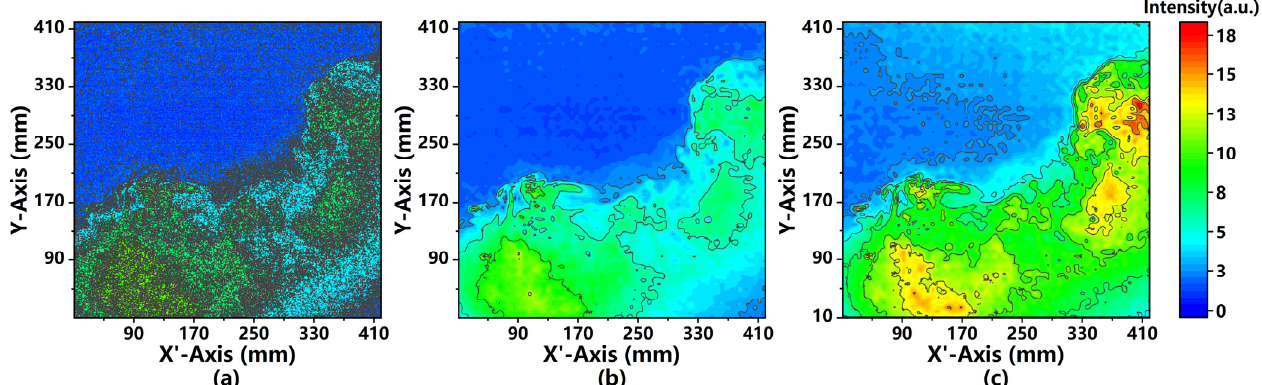
Figure 7. The 2D intensity distribution of planar laser-induced fluorescence (PLIF) images captured at the 20th second. The signals in ( a ) were processed with background subtraction and pixel merging, the signals in ( b ) were processed with background subtraction, pixel merging, and wavelet denoising, and the signals in ( c ) were further processed with geometric correction, in addition to the above mentioned three methods. The concentration of the atomized fluorescein solution was 0.1 g/L, and the signals were obtained with the laser power of 100 mW, a 25 ms frame, and an atomization rate of 0.5 mL/s.